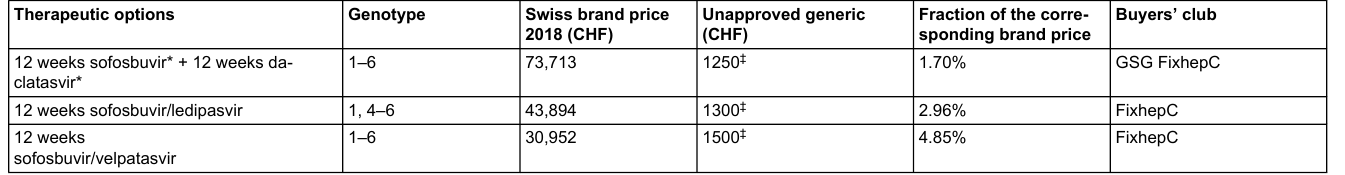
Table 2: Comparison of the Swiss cost of treatment using brand medications versus the corresponding unapproved generics available through a buyers’ club. Therapeutic